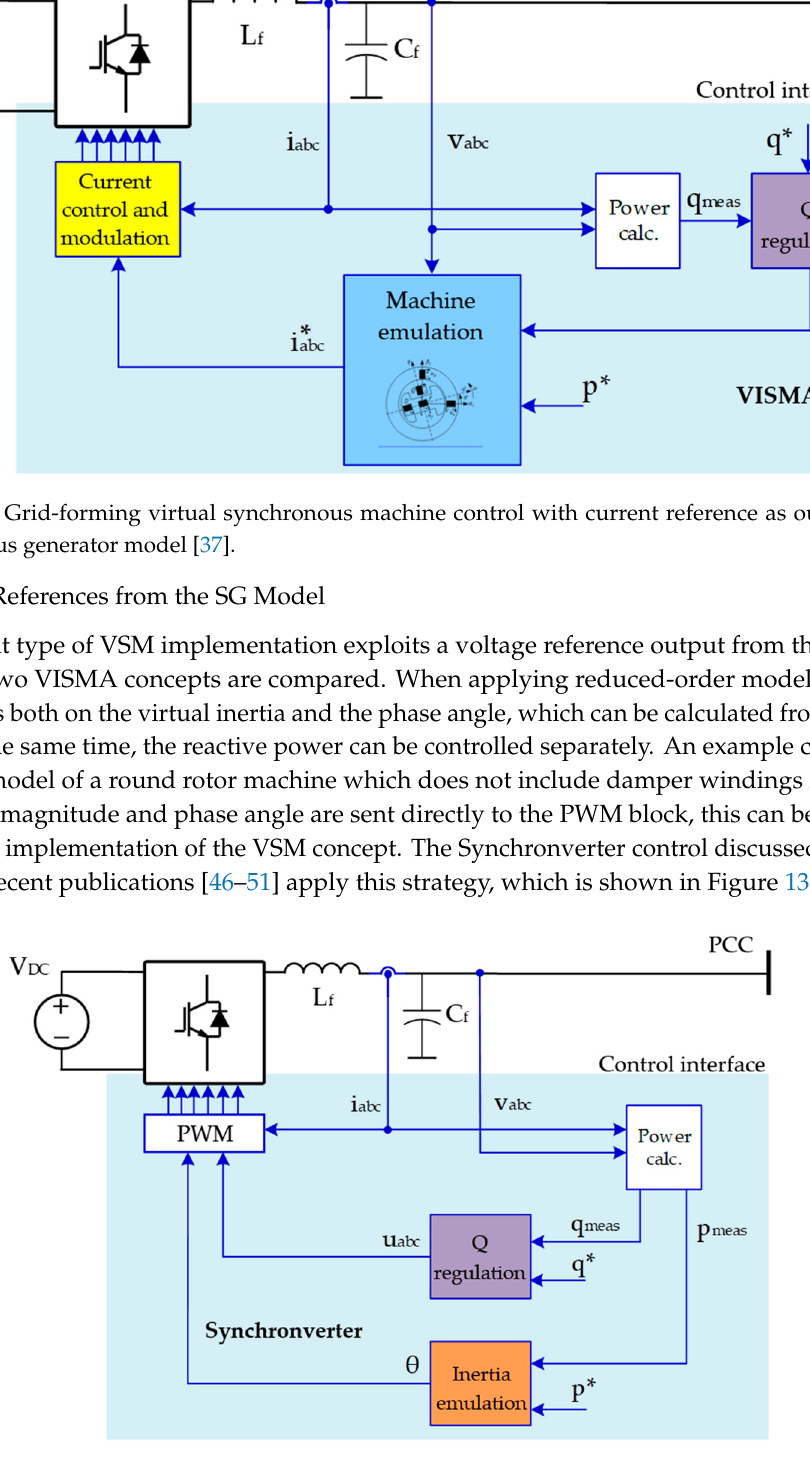
Figure 13. Grid-forming virtual synchronous machine control with the current reference as an output of the synchronous generator model [36].